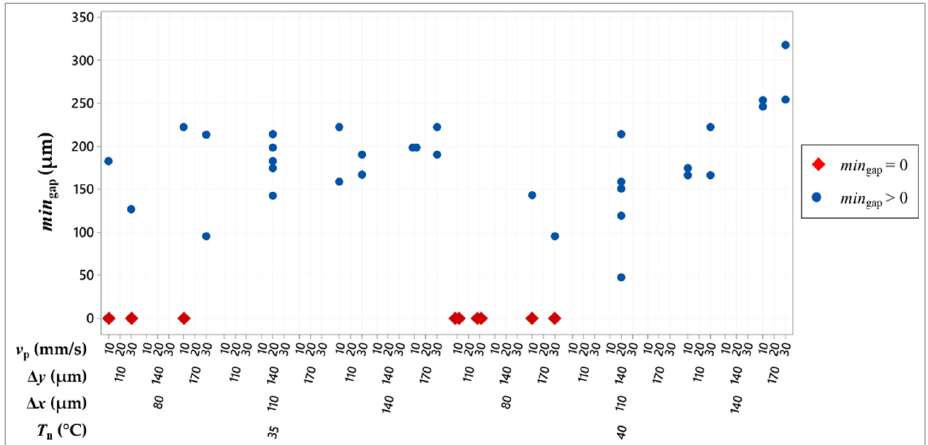
Figure 10. Individual value plot of the minimum value of the gap.